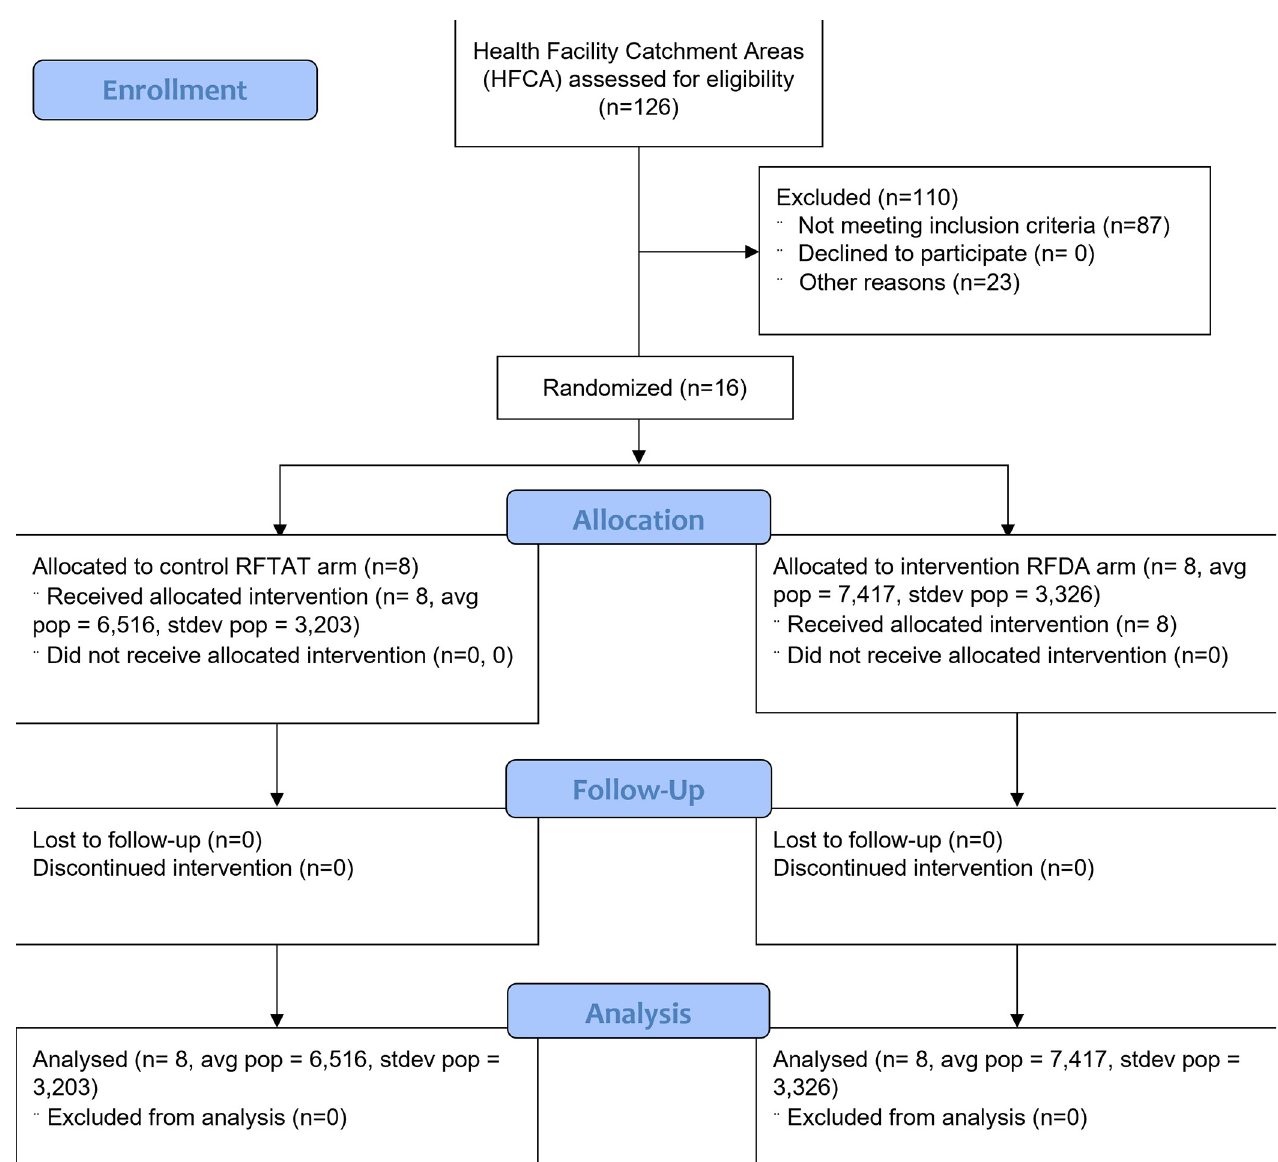
Fig 1. Study participant flow. Sixteen clusters were selected from all eligible health facility catchment areas in Southern Province,